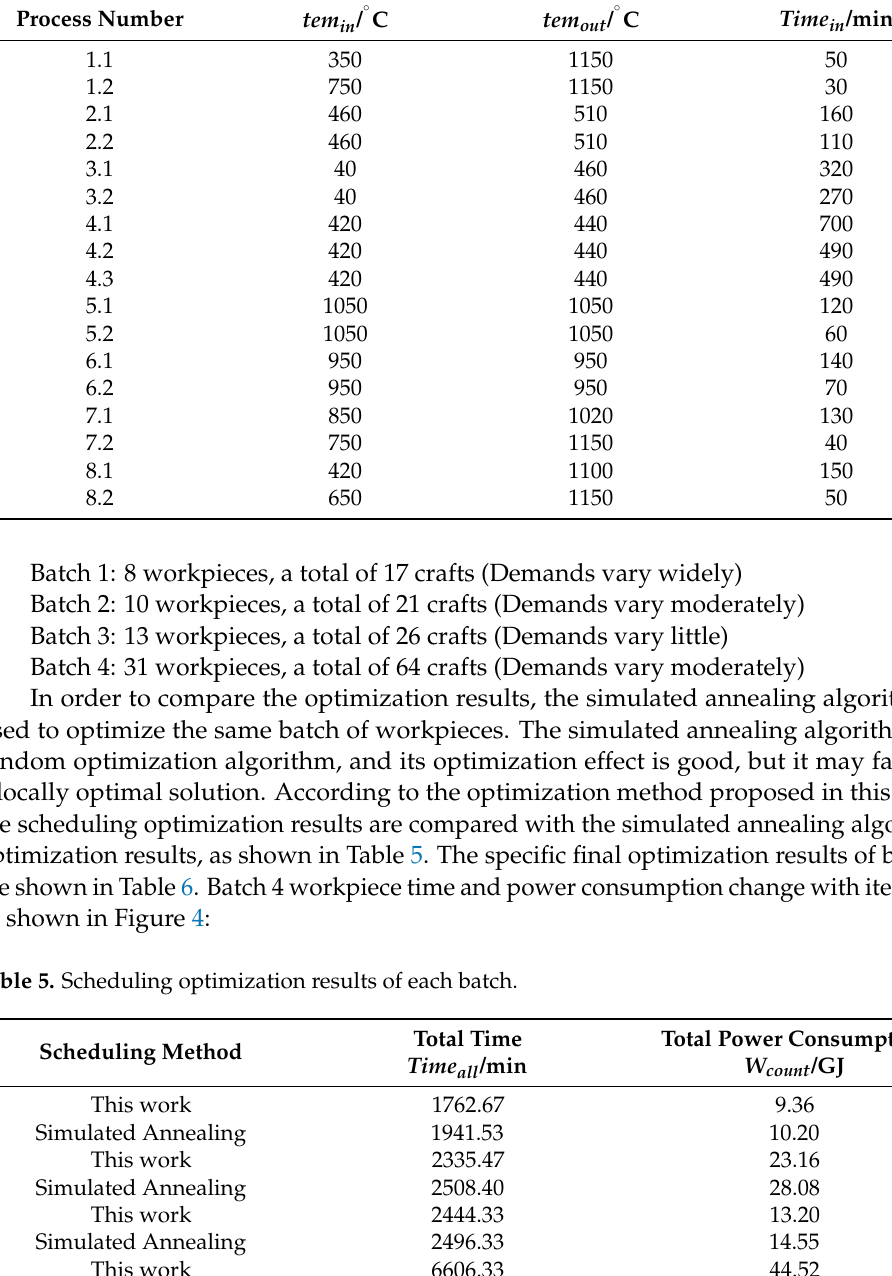
Table 4. Specific process requirements of batch 1.